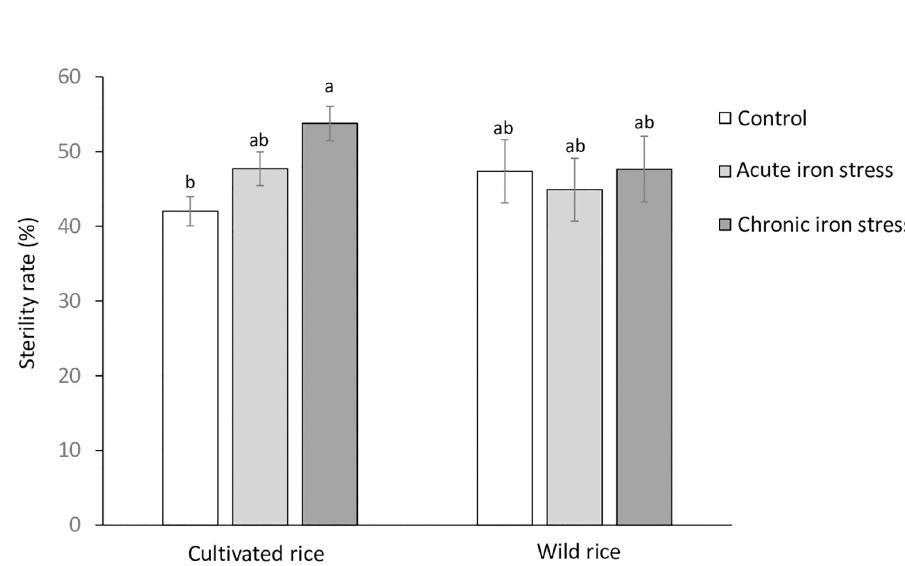
Fig 3. Sterility rates of cultivated and wild rice species in control conditions, acute and chronic Fe toxicity. Mean values and standard errors are plotted (n = 33–115). Bars not sharing the same letter differ from each other at P < 0.05 by Tukey’s HSD